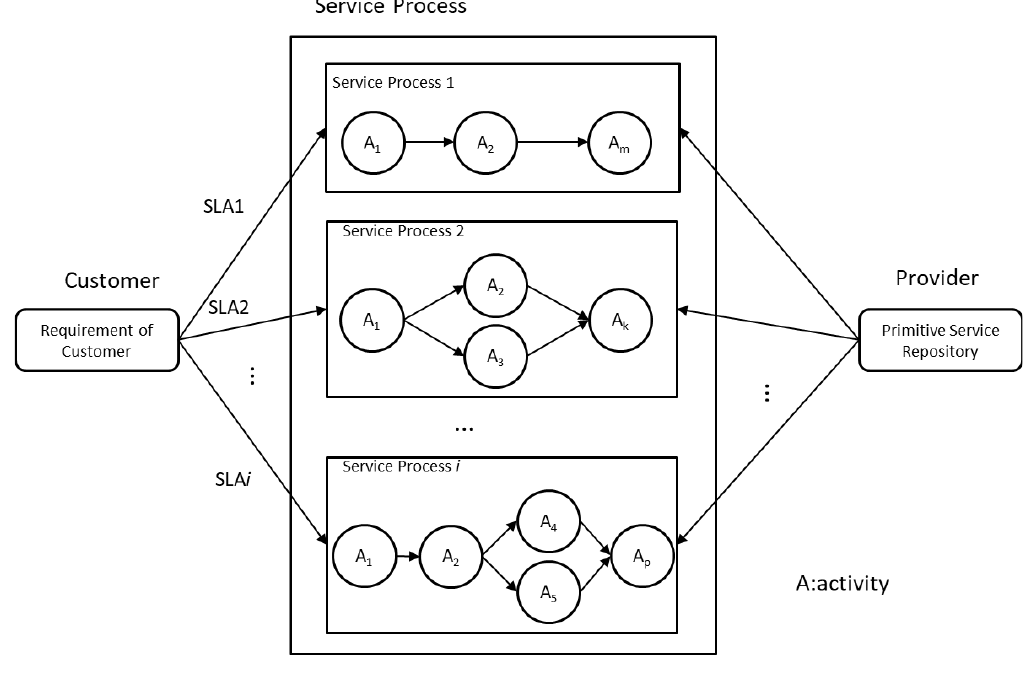
Figure 2. Process and activity.